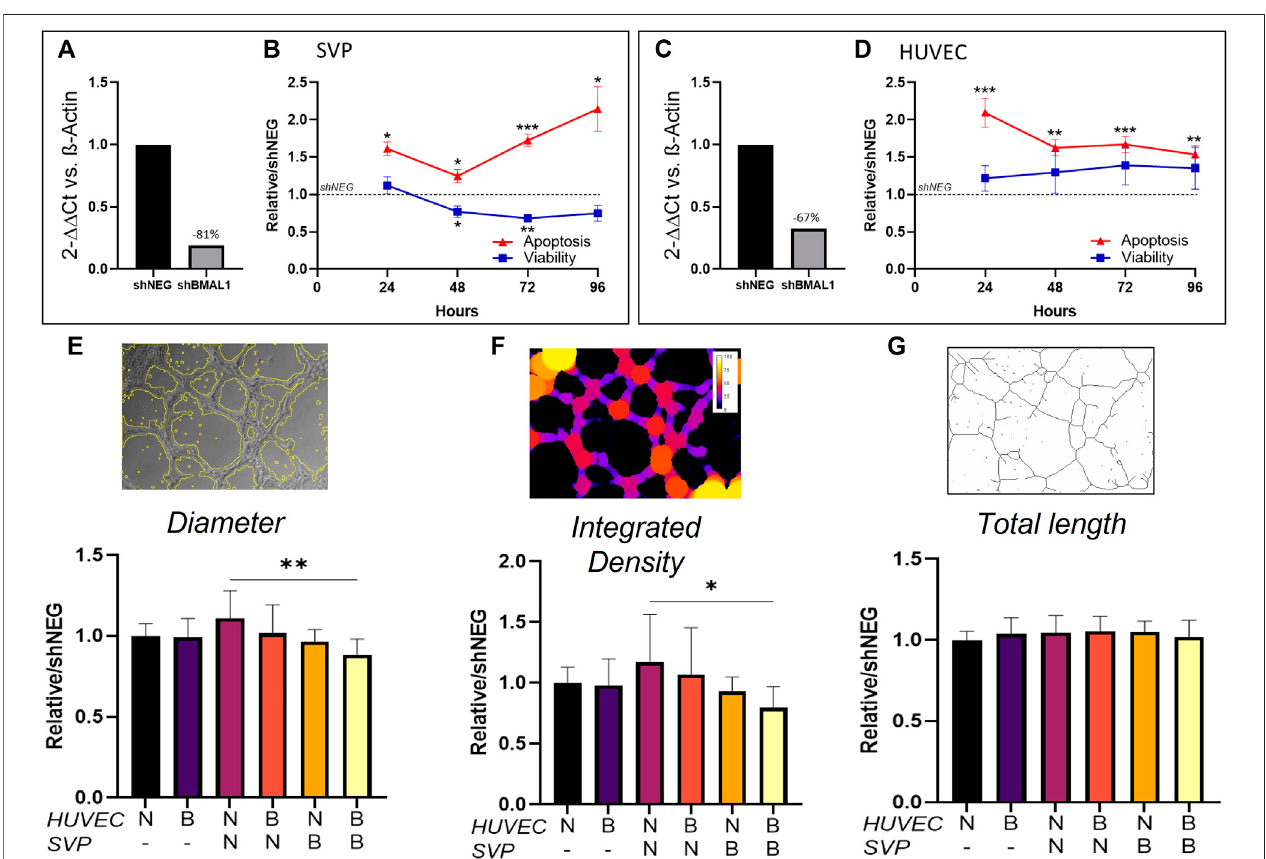
FIGURE 3 | Clock disruption affects tube formation in Matrigel assay. Bmal1 mRNA expression in saphenous vein pericytes (SVP, (A) ) and in human umbilical vein endothelial cells (HUVEC, (C) ) in knockdown cells (shBMAL1) in comparison with control cells (shNEG). The data are shown as 2 − ΔΔ Ct and normalized on β -actin housekeeping mRNA expression. Fold change in viability and apoptosis of shBMAL1 cells over time, relative to shNEG cells in SVP (n = 4, (B) ) and HUVEC (n = 4, (D) ), respectively. Relative average branch thickness ( (E) , Diameter), network coverage ( (F) , Integrated density) and total branch length ( (G) , Total length) measured in HUVEC(H)cultured alone orinco-culture withSVP(S)on Matrigel. Differentcombination ofshNEGcells(N)andshBMAL1(B)cellsarecompared.Representativemask pictures of the analysis are shown. Data were analyzed using two-way ANOVA, and * = p < 0.05, ** = p < 0.01, *** = p < 0.001 vs. shNEG or wild-type co-cultures.